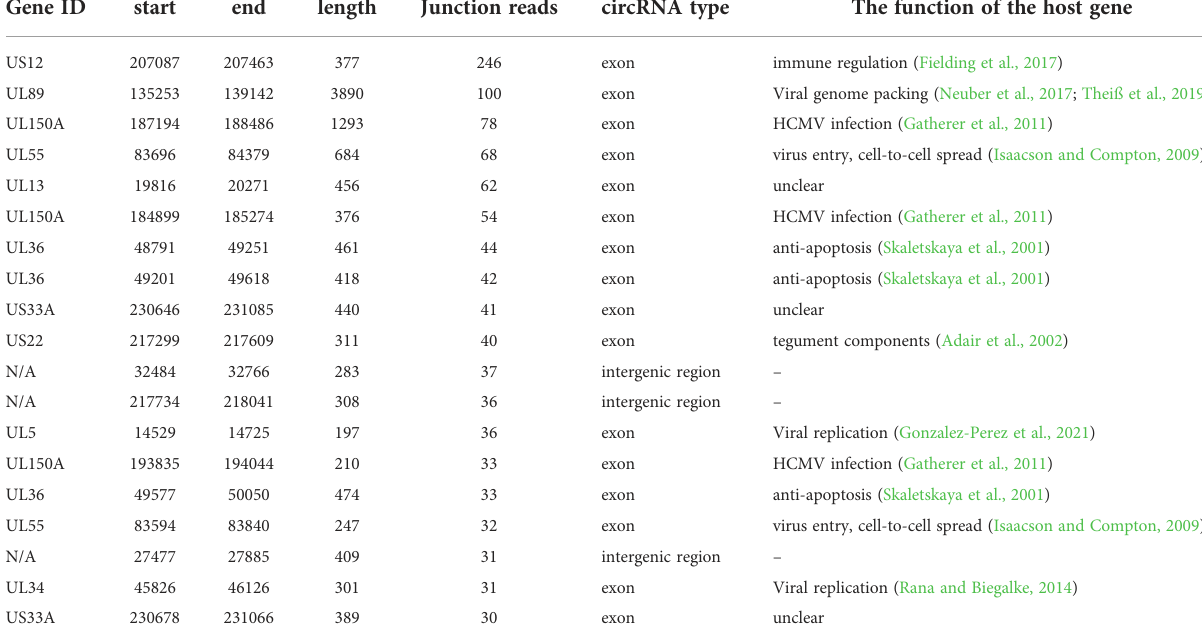
TABLE 1 The top 20 HCMV-encoded circRNAs in